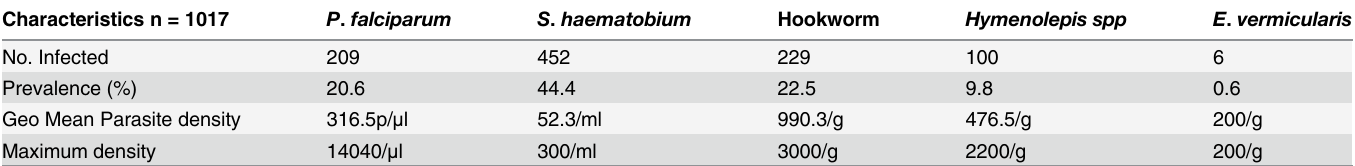
Table 1. Overall prevalence and infection intensities (expressed as geometric mean parasite count of positive samples) of parasitic infections in school children in Kwara State Nigeria. Characteristics n = 1017